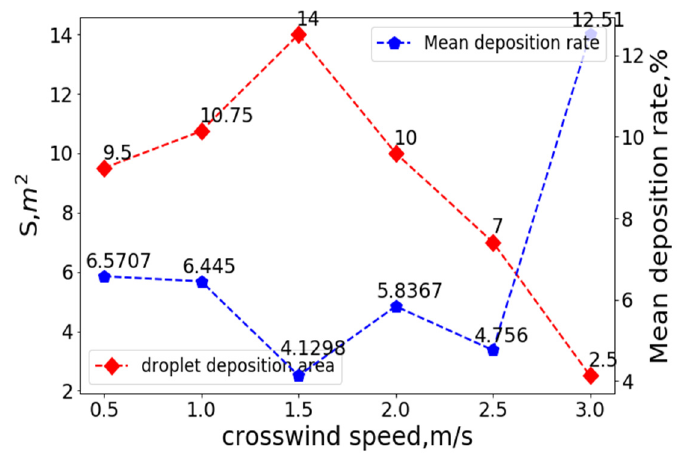
Figure 17. Variation curves of the coverage area, S, and mean droplet deposition rate at a flight height of 3 m, flight speed of 0 m/s, and different crosswind speeds.